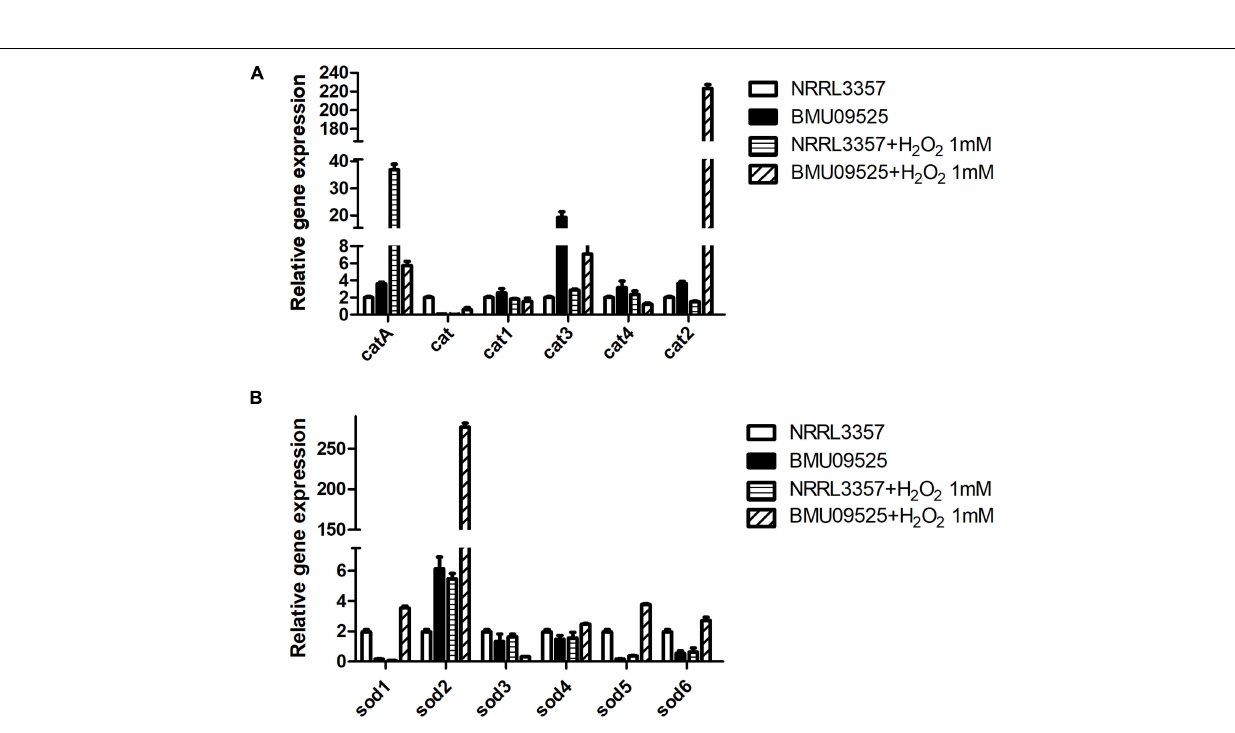
Frontiers in Microbiology |